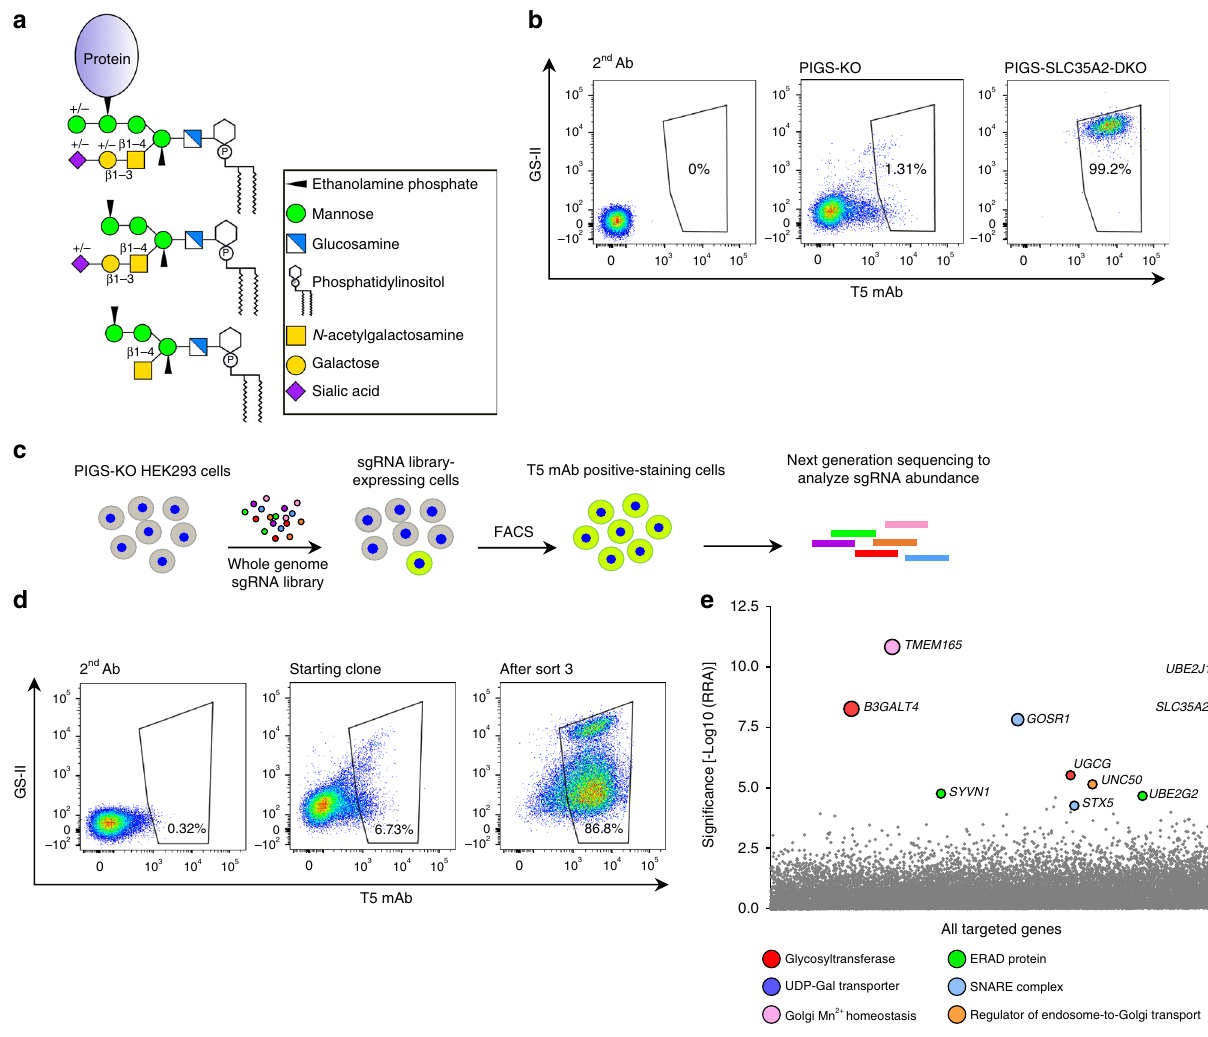
Fig. 1 CRISPR-based genetic screen identi fi ed genes involved in galactosylation of GPI. a GPI-APs and free GPIs with side-chain modi fi cations. Monosaccharide symbols are drawn according to the symbol nomenclature for glycans 77 . b Flow cytometry analysis of PIGS knockout (PIGS-KO) and PIGS-SLC35A2-DKO HEK293 cells. Cells were double stained with T5 mAb for free GPI-GalNAc and GS-II lectin. c Schematic depicting a FACS-based genome-wide CRISPR screen for GPI-galactosylation using PIGS-KO HEK293 cells. d Flow cytometry analysis of starting clone and sort3 of PIGS-KO cells stained with T5 mAb and GS-II lectin. e Gene scores in unsorted versus sort3 PIGS-KO cells. Ten top-ranking ER or Golgi protein-coding genes are shown. Bubble size shows the number of active sgRNAs per gene. See also Supplementary Fig. 1e,